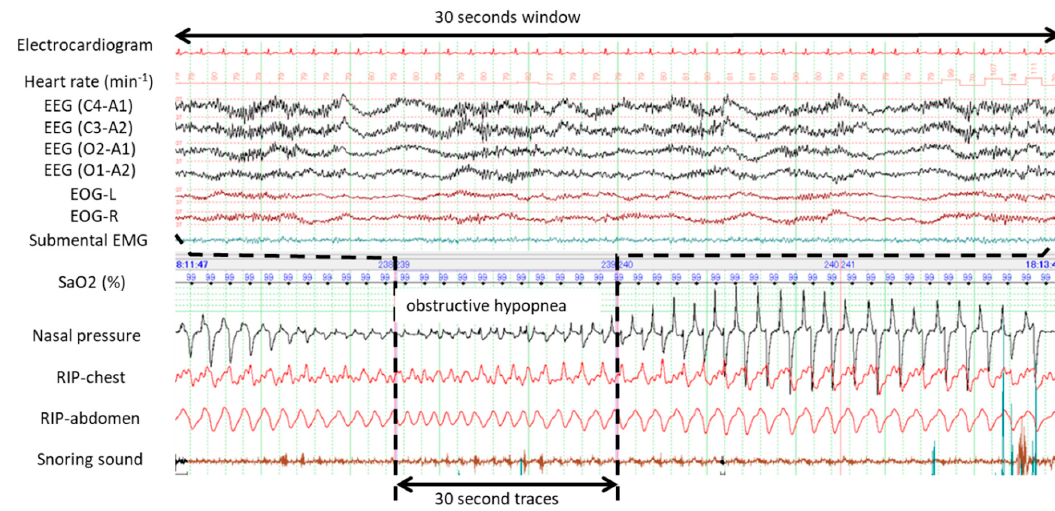
Figure 3. Typical polysomnographic example of obstructive hypopnea occurred during ESD procedure under propofol sedation. No cortical arousal was detected by the electroencephalograms (EEG) during the recovery from hypopnea. Note inspiratory flow limitation pattern of the nasal pressure signal and progressive increase of the inspiratory period. Also note the gradual increase of the respiratory flow during recovery from hypopnea unlike the sudden increase of the respiratory flow commonly seen in obstructive hypopnea during natural sleep.